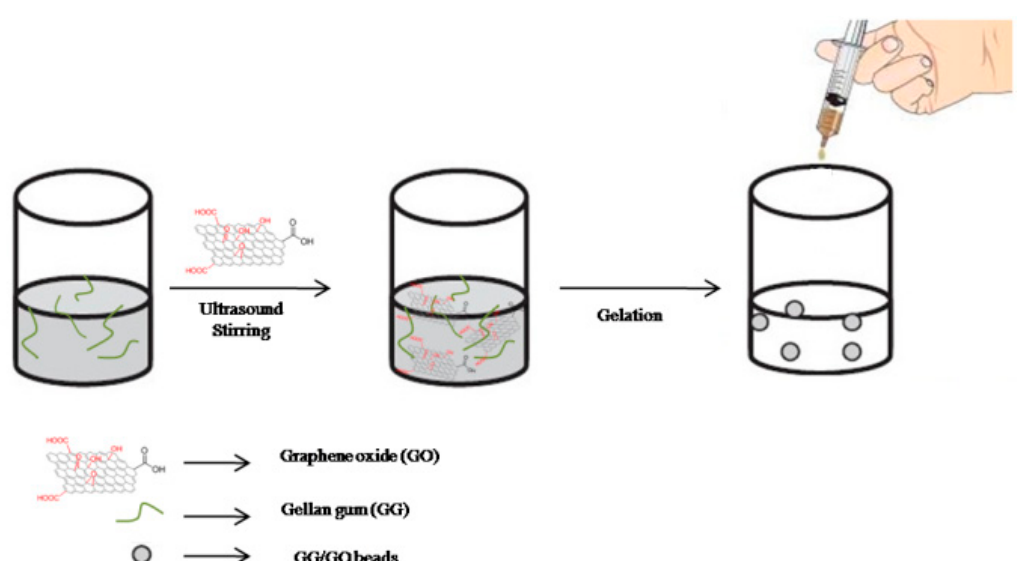
Figure 1. Synthesis protocol of gellan gum/graphene oxide (GG/GO) hydrogel composite beads.